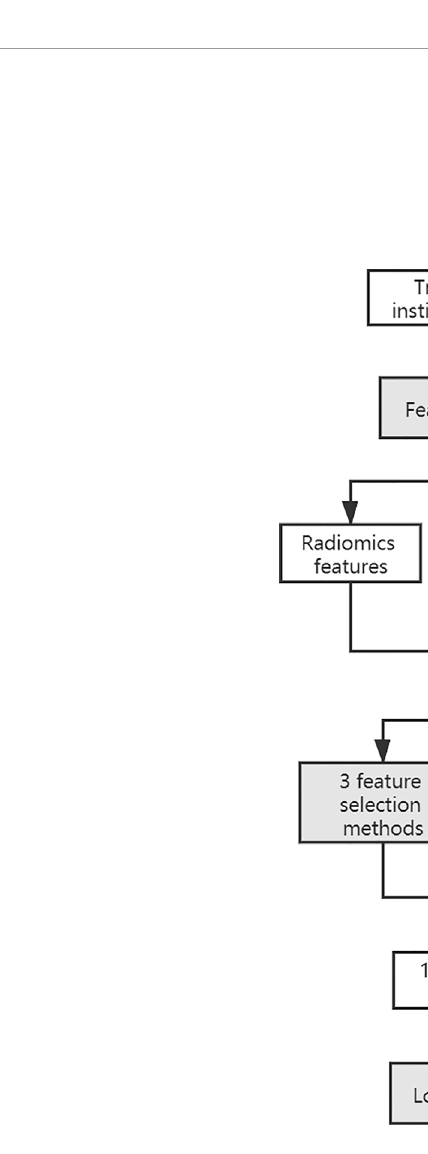
FIGURE 1 | Schematic shows work fl ow for this